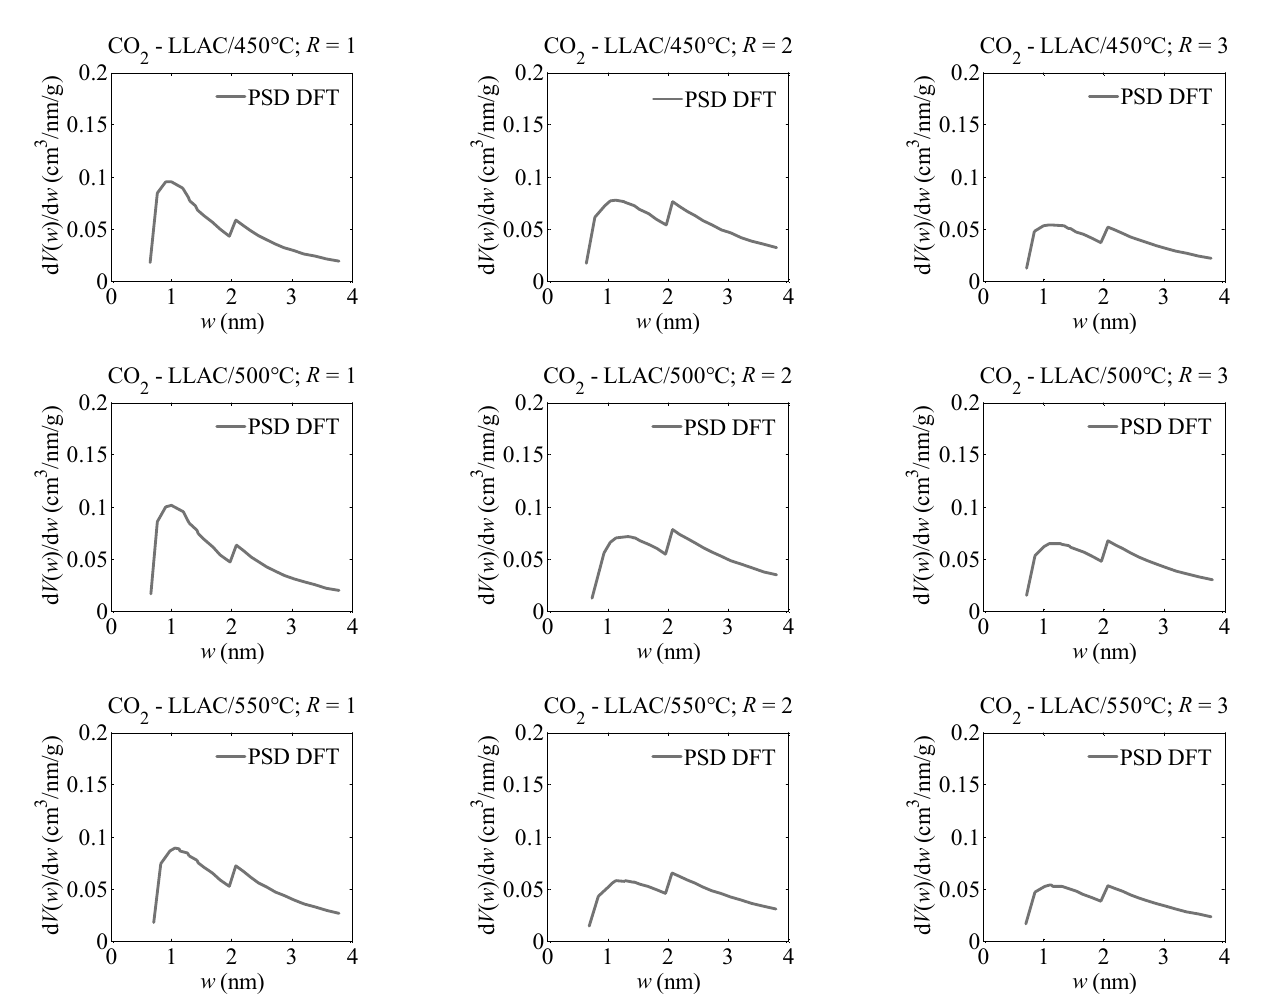
Figure 2. The pore size distributions obtained for the analysed active carbons using the DFT method. In the case of the sample obtained at 550 ◦ C, a significant decrease in the value of the specific surface area was observed already at mass ratio, R , equal to 2, in comparison with the value obtained at R = 1, and successively, a further decrease in the value of this